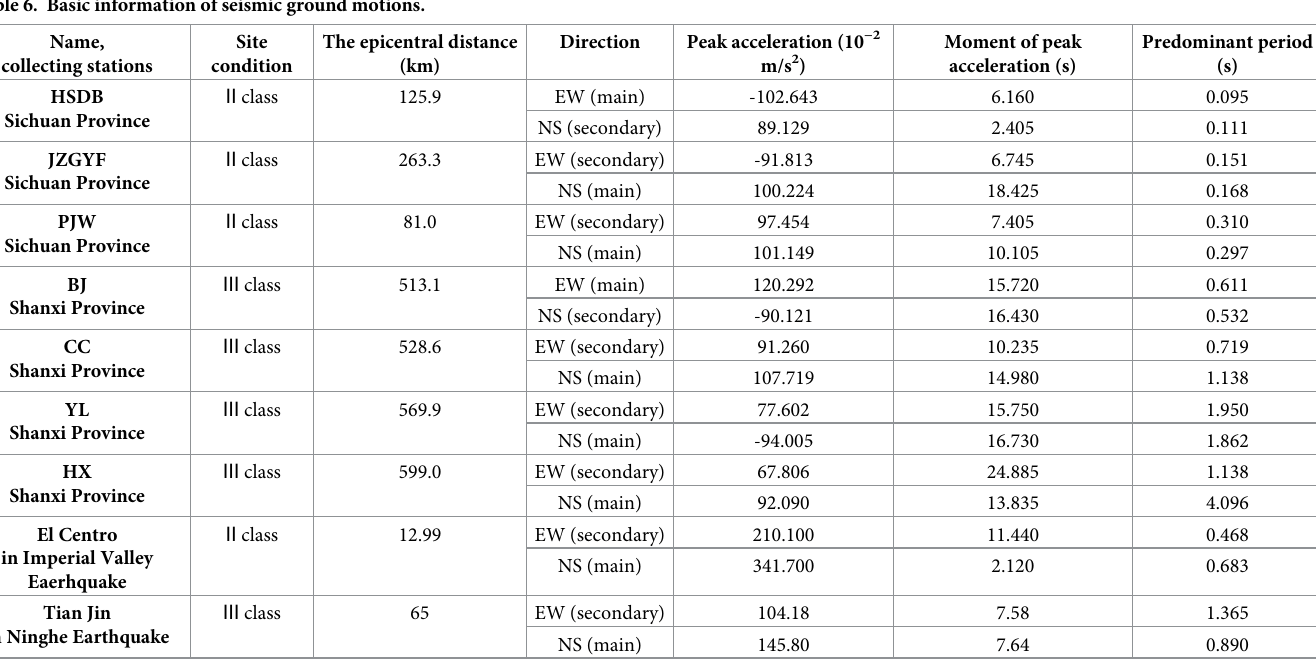
Table 6. Basic information of seismic ground